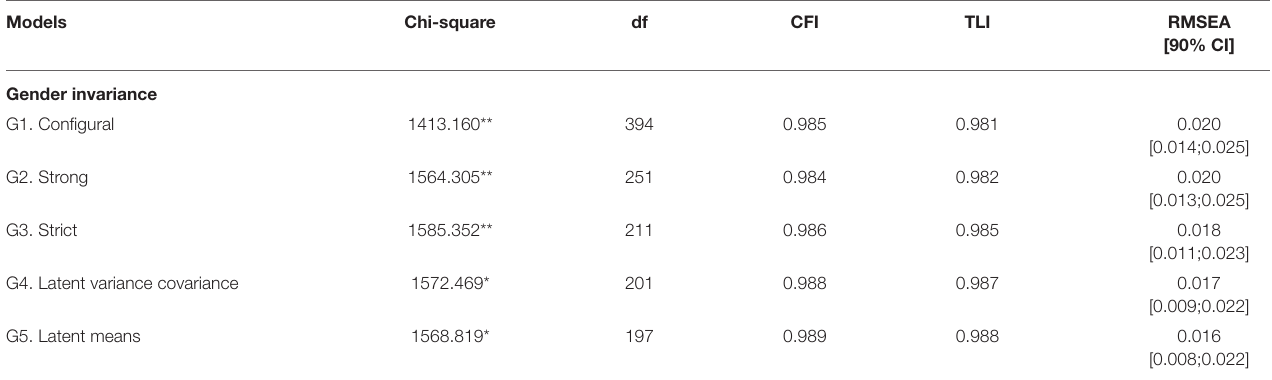
TABLE 5 | Measurement invariance across gender for the bifactor-ESEM representation of early numeracy with one global factor and three specific facets (Model 8).